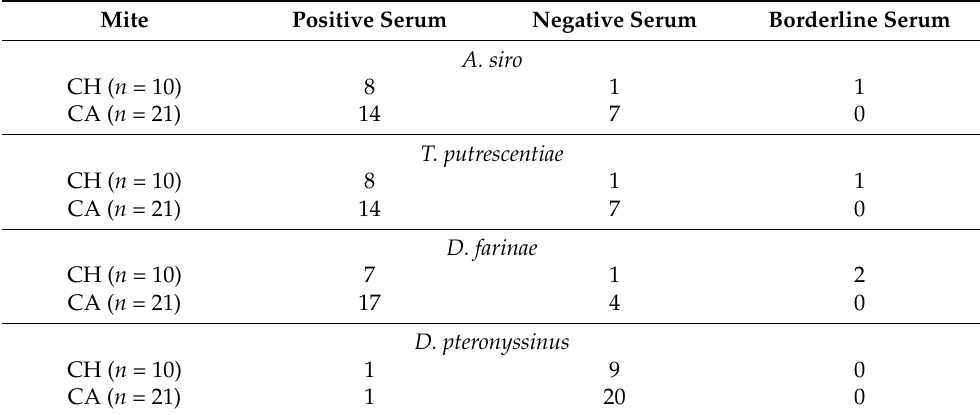
Table 1. The presence of mite-specific IgE antibodies in sera of clinically healthy (CH) and clinically allergic (CA)